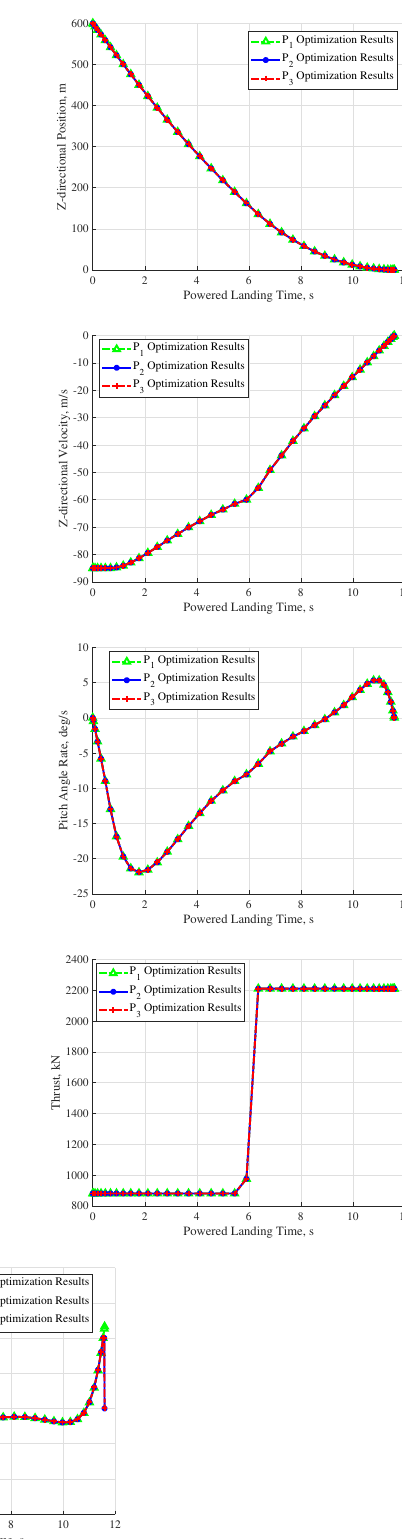
Figure 2. Comparison of optimization results for P 1 , P 2 and P 3